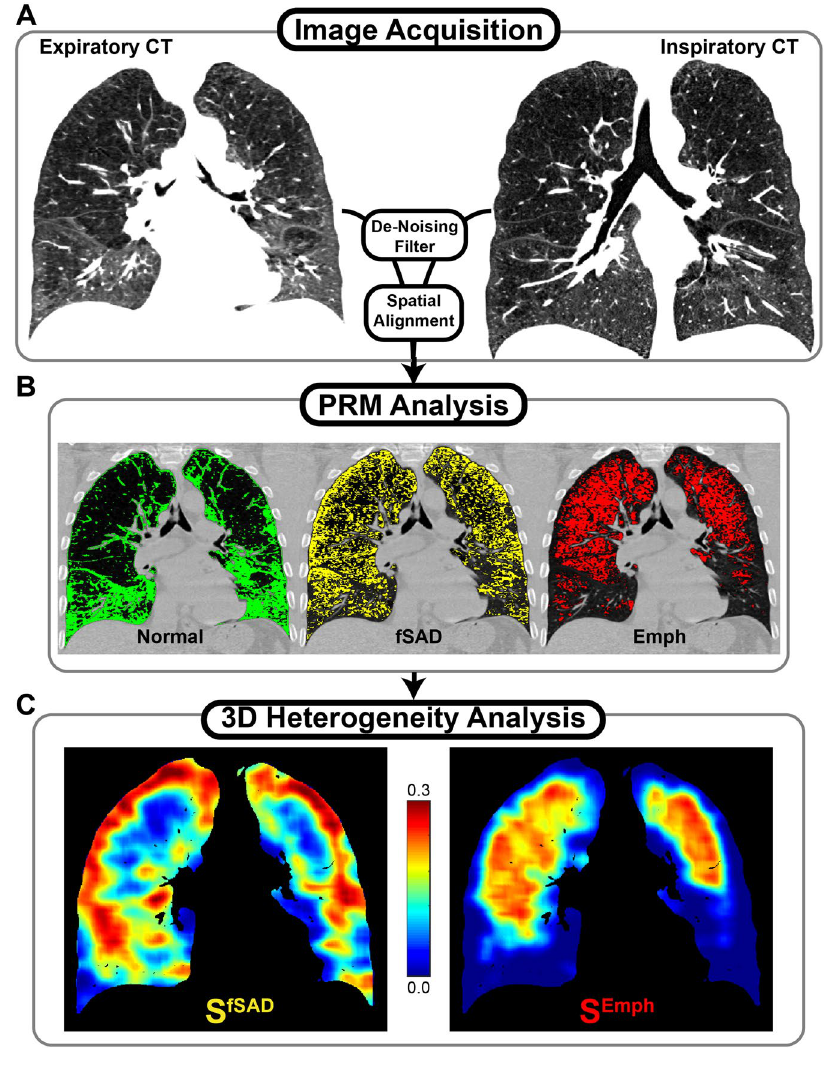
Figure 1. A schematic of the workflow is displayed for generating PRM topological maps. ( A ) CT images are acquired at expiration and inspiration. ( B ) PRM analysis is performed by first segmenting the lungs from the thoracic cavity. Then the CT images are filtered and spatially aligned to the expiration geometric frame. Individual voxels are then classified as normal (PRM Norm , green), functional small airways disease (PRM fSAD , yellow), or emphysema (PRM Emph , red). ( C ) Topological feature extraction is performed on each PRM classification binary map to determine topology metrics. Presented are surface area (S) maps for PRM fSAD (left) and PRM Emph